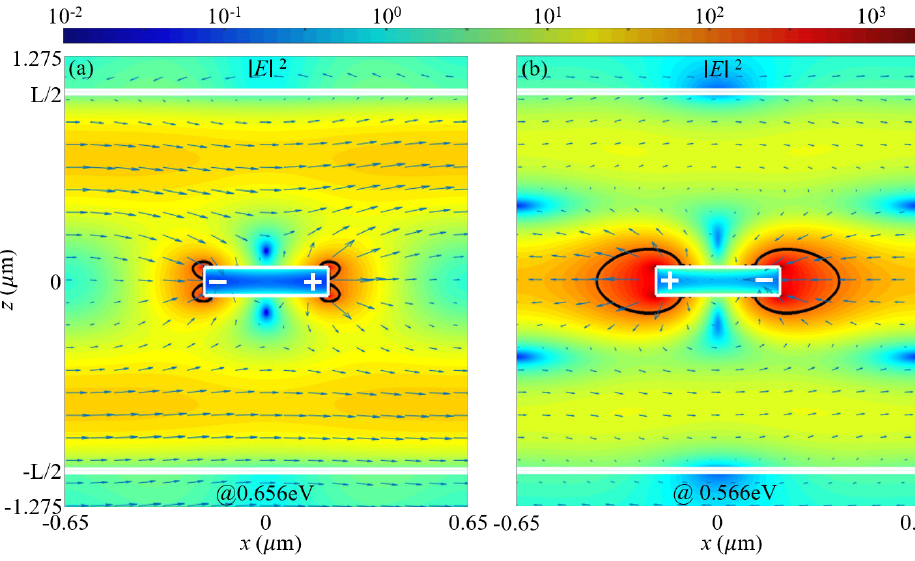
Figure 4. Similar to Figure 3e,f but for the split modes due to the strong coupling between the SLR and the third-order F-P resonance. These modes are resonant at ( a ) 0.656 eV and ( b ) 0.566 eV. The calculations were performed with L = 2147